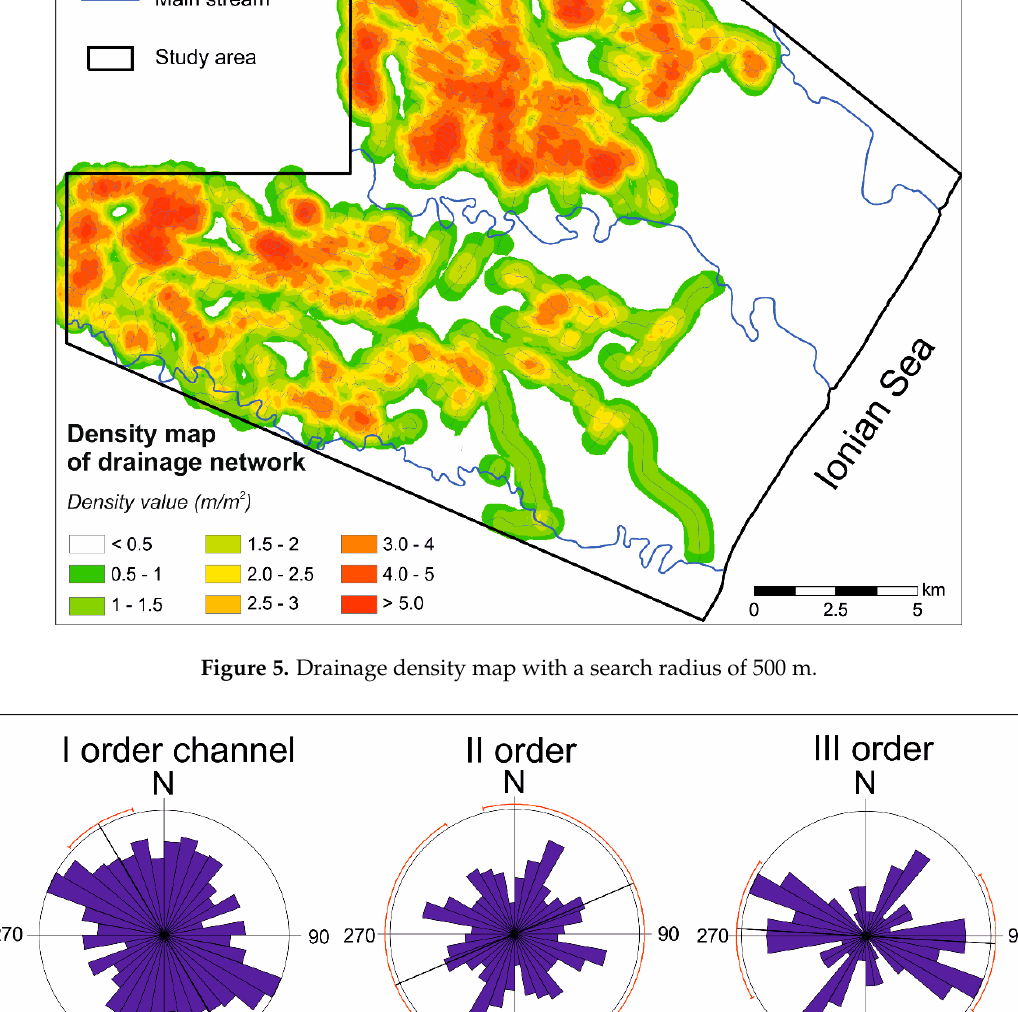
Figure 5. Drainage density map with a search radius of 500 m.